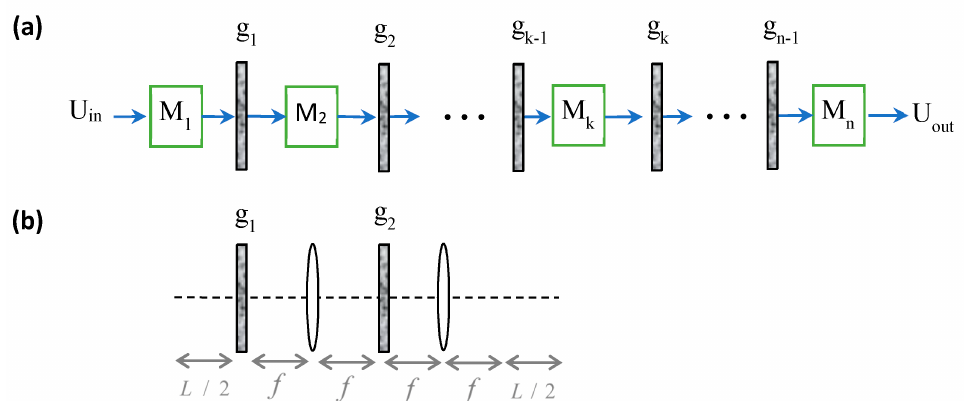
Figure 1. ( a ) A first-order paraxial optical system with n sub paraxial systems M 1 , M 2 . . . M k . . . M n with arbitrary multiple masks g 1 , g 2 . . . g k − 1 , g k . . . g n − 1 placed at arbitrary positions. U in and U out denote the input field and output field. ( b ) A private case of ( a ) for two random phase masks and three sub-systems. By choosing appropriate system properties, the set-up represents a medium with an optical memory effect.